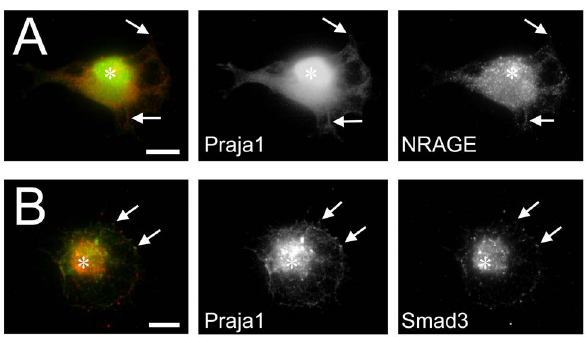
Figure 3. Co-localization of Praja1 with its putative substrates NRAGE and Smad3 in PC12 cells. (A) EGFP::Praja1 (green) co- localizes with NRAGE (red) in the nucleus (asterisk), at distinct positions at the membrane and along filamentous structures in the cytosol (arrows). (B) Co-localization of EGFP::Praja1 and Smad3 is also observed in the nucleus and on few points at the plasmamembrane (arrow). No difference was observed between experiments using transcript variant praja1.1 and praja1.2 . Bars: 10 m